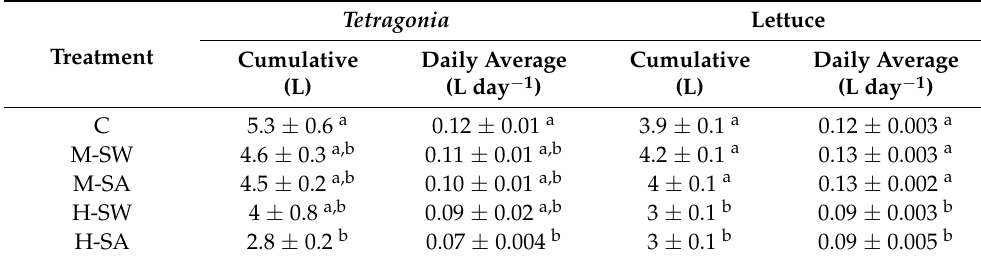
Table 3. Cumulative and daily average